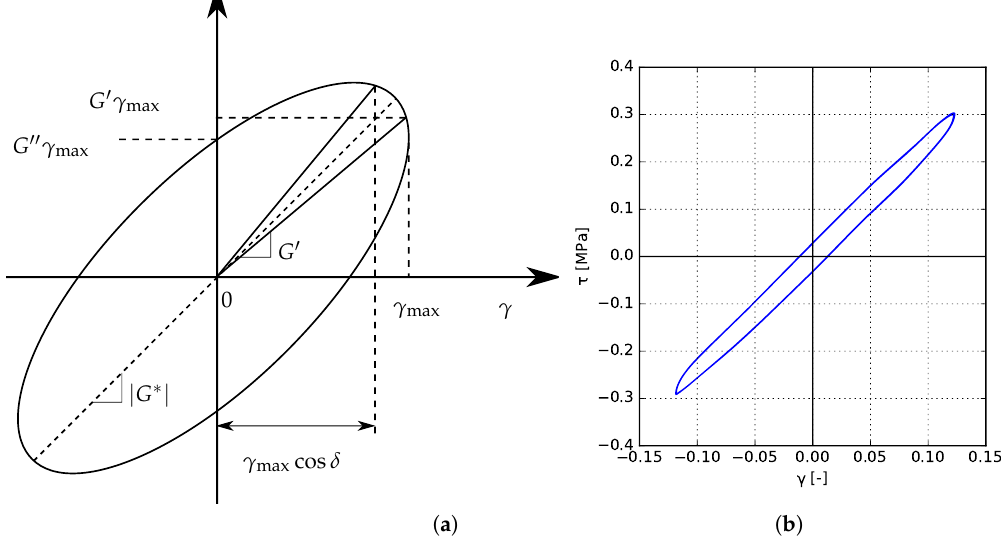
Figure 8. Viscoelastic loop of dynamic stress–strain relation in a loading cycle: ( a ) illustrative scheme showing all important points, ( b ) example of EVA stress–strain relation observed during